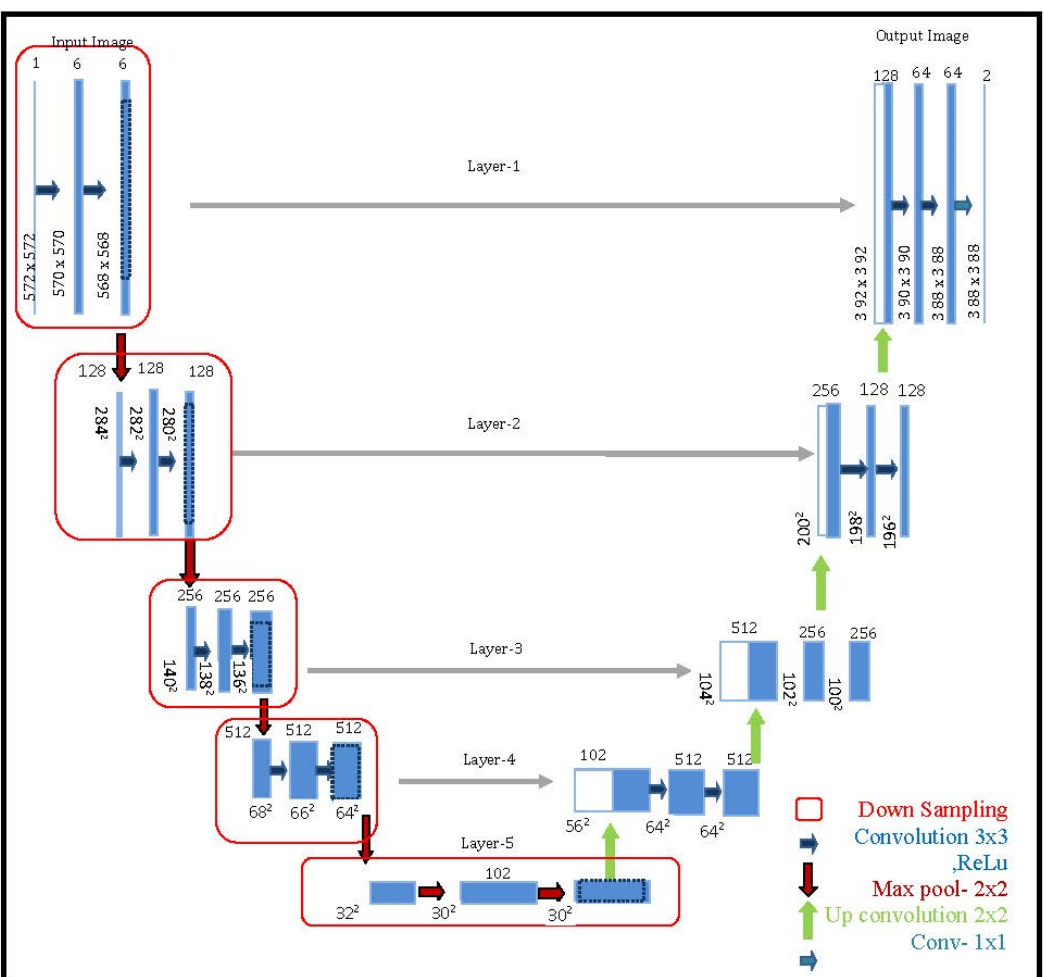
Figure 3. Five-Layer U-Net based Architecture.